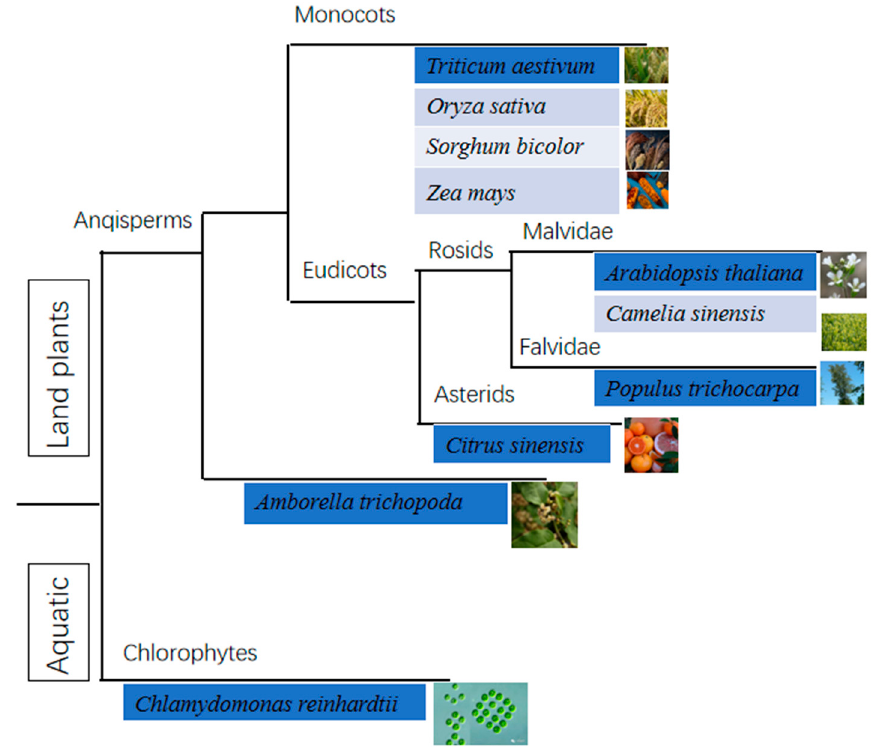
Figure 2. The phylogenetic tree of Monocotyledonous and eudicotyledonous plants. The obtained 9022 OGs and 392,812 NOGs were identified with label 1 and label 0,